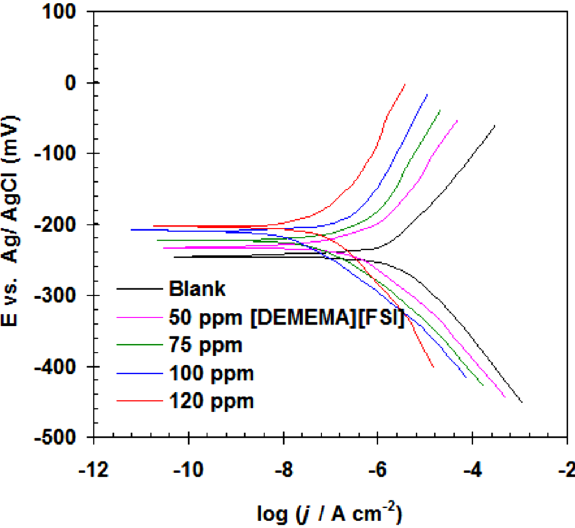
Figure 1. Polarization curves of Cu–Ni alloy in (3.5% NaCl + 10 ppm sulfide) solution in the absence and presence of [DEMEMA][FSI] at 298